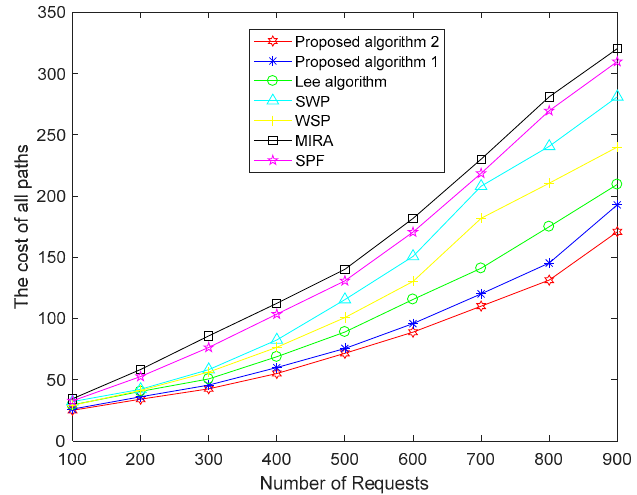
Figure 4. The cost of all paths of the seven algorithms.